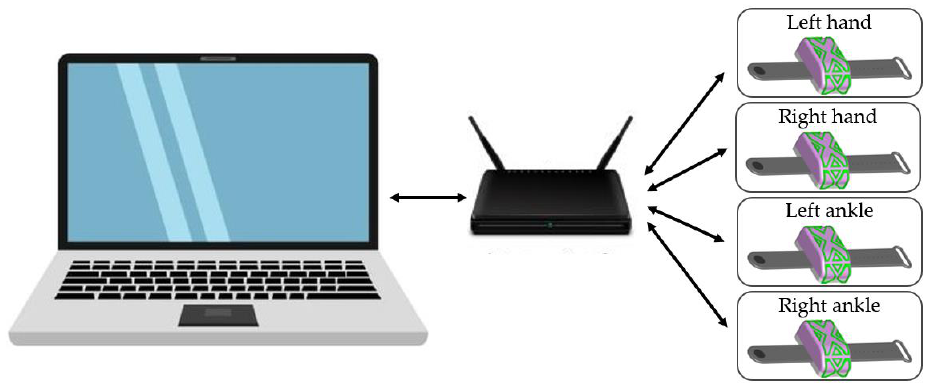
Figure 10. Motion sensors ’ system architecture diagram.